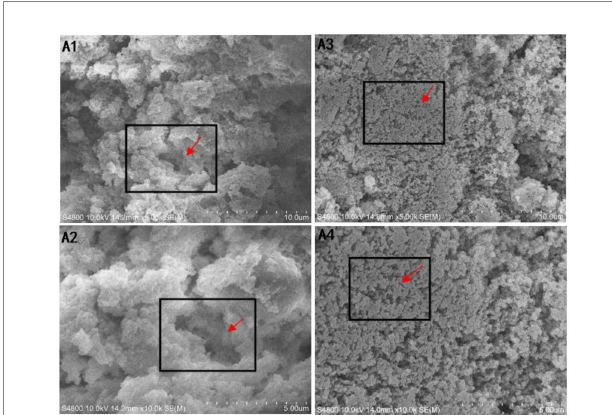
FIGURE 6 Comparison of gel microstructure between SDEW and SDEW-XG. A1: Gel made from SDEW (5.0 k magnification); A2: Gel made from SDEW (10.0 k magnification); A3: Gel made from SDEW-XG (5.0 k magnification); A4: Gel made from SDEW-XG (10.0 k magnification).